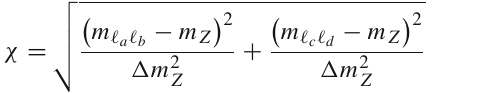
(Sect. 4), by considering the prospective model-independent bounds on the quantity κ = σ H /σ SM nal cross section for the respective channel, i.e., V V or hh